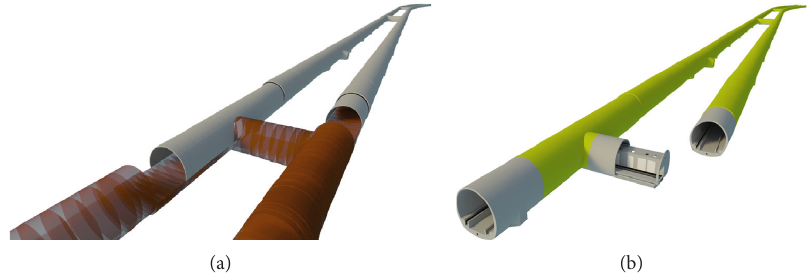
Figure 4: BIM models of tunnel excavation and support (a) and tunnel inner lining